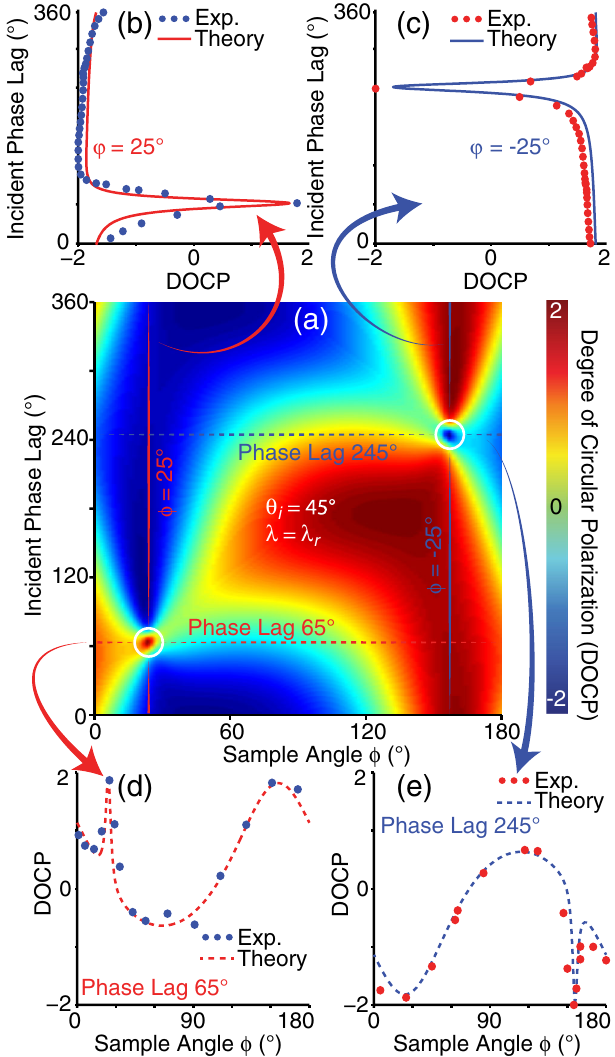
FIG. 7. Polarization properties of the reflected light under elliptical illumination. (a) Theoretical surface plot of the degree of circular polarization (DOCP) at λ r as function of ϕ and phase lag between the incident p and s polarizations. The DOCP at λ r as function of (b),(c) the phase lag and (d),(e) ϕ . The horizontal and vertical lines in (a) correspond to the data in (b) – (e). The markers denote experimental data, and the lines are